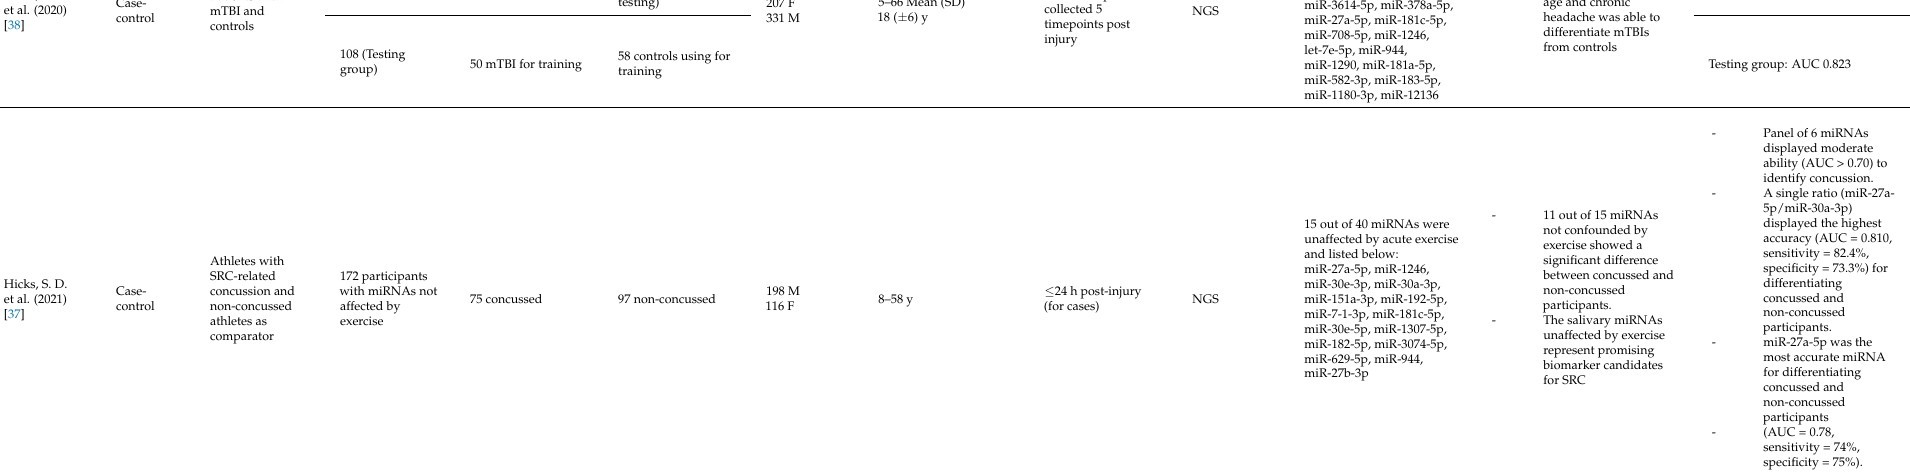
ThesalivarymiRNAs unaffectedbyexercise representpromising biomarkercandidates forSRC